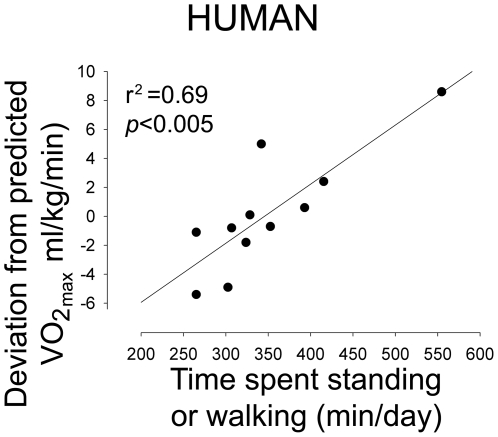
People with higher endurance had higher daily non-exercise activity.VO2max (deviation from predicted VO2max based on age, sex, and body weight) was significantly positively correlated with time spent standing or walking in healthy human volunteers.